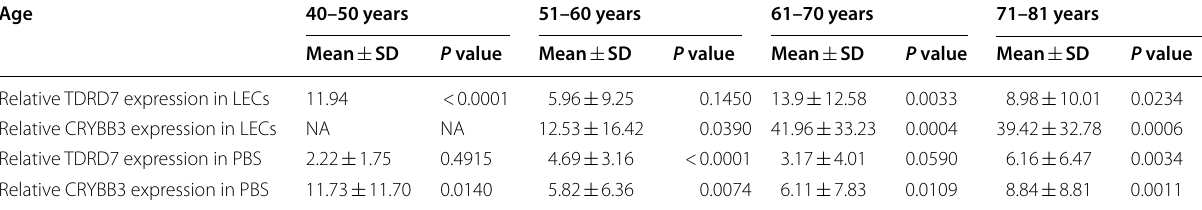
Table 1 The expression levels of TDRD7 and CRYBB3 by age groups